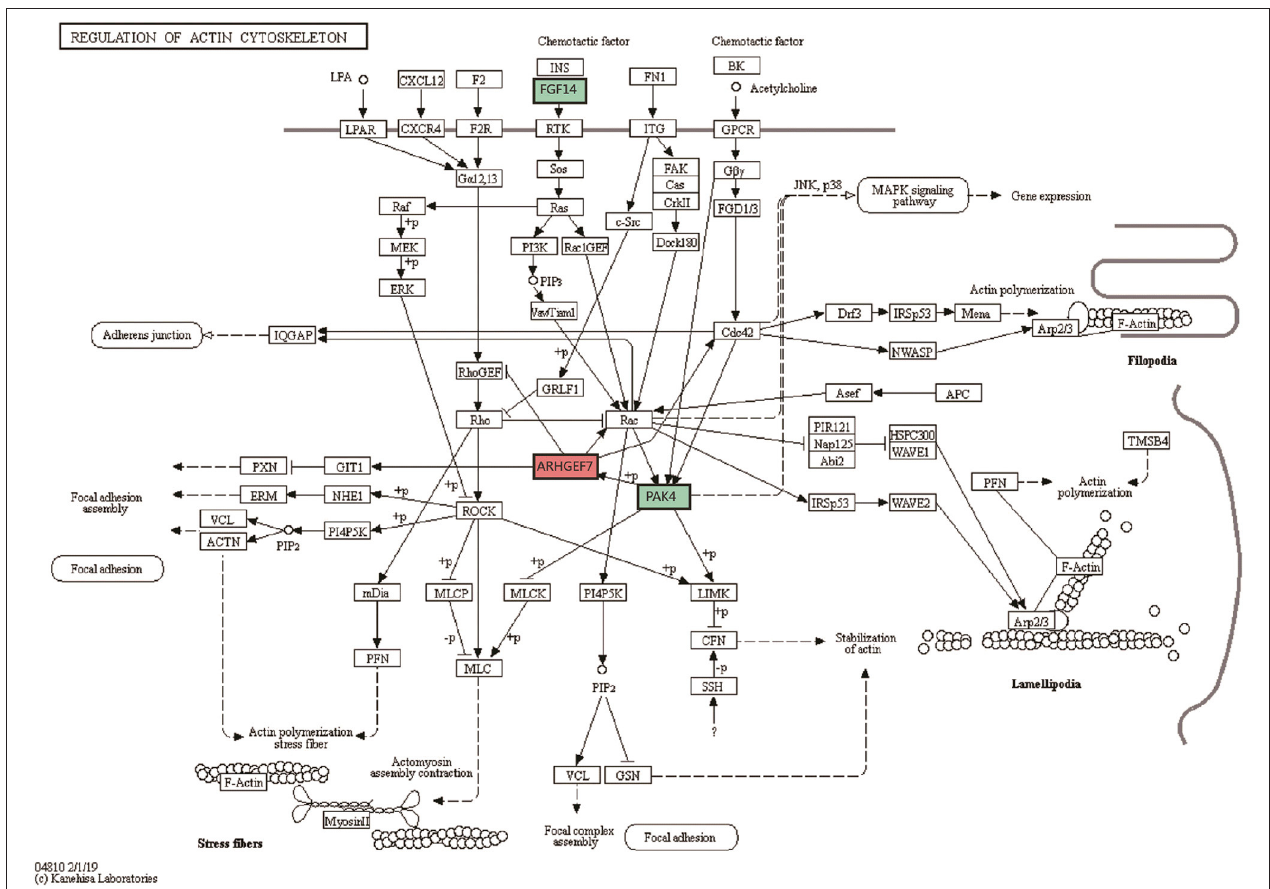
FIGURE 1 | Signaling pathways regulating the actin cytoskeleton. Diagram of the most significant signaling pathways in which the differentially expressed genes in the XYS group were involved compared with the model group. The green label represents the downregulated FGF14 and PAK4 genes; the red label represents the upregulated ARHGEF7